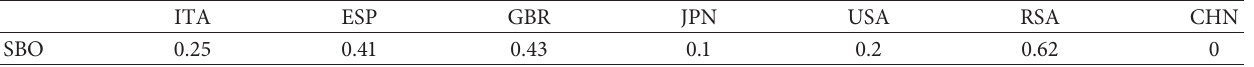
Table 1: The buffer levels of the strengthening buffer operator for different countries.